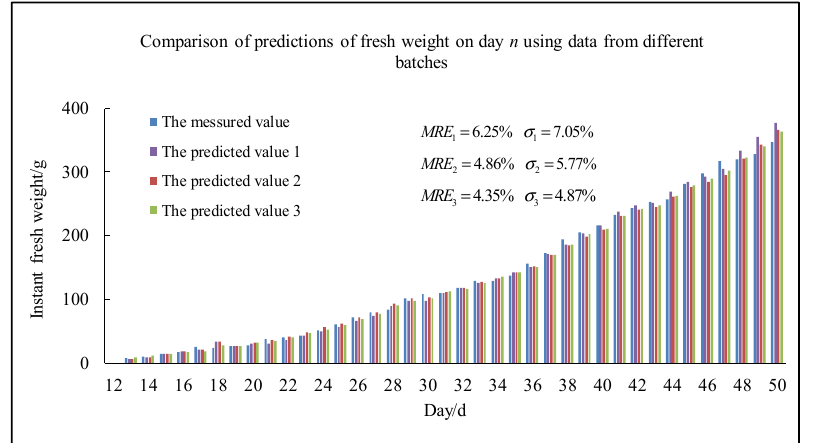
Figure 8. Prediction of fresh weight on the next day. Note: Predicted value 1 is the value of fresh weight on the next day predicted using the data of the current batch. Predicted value 2 is the value of fresh weight on the next day predicted by introducing another batch. Predicted value 3 is the value of fresh weight on the next day predicted by introducing the data from another 2 batches.